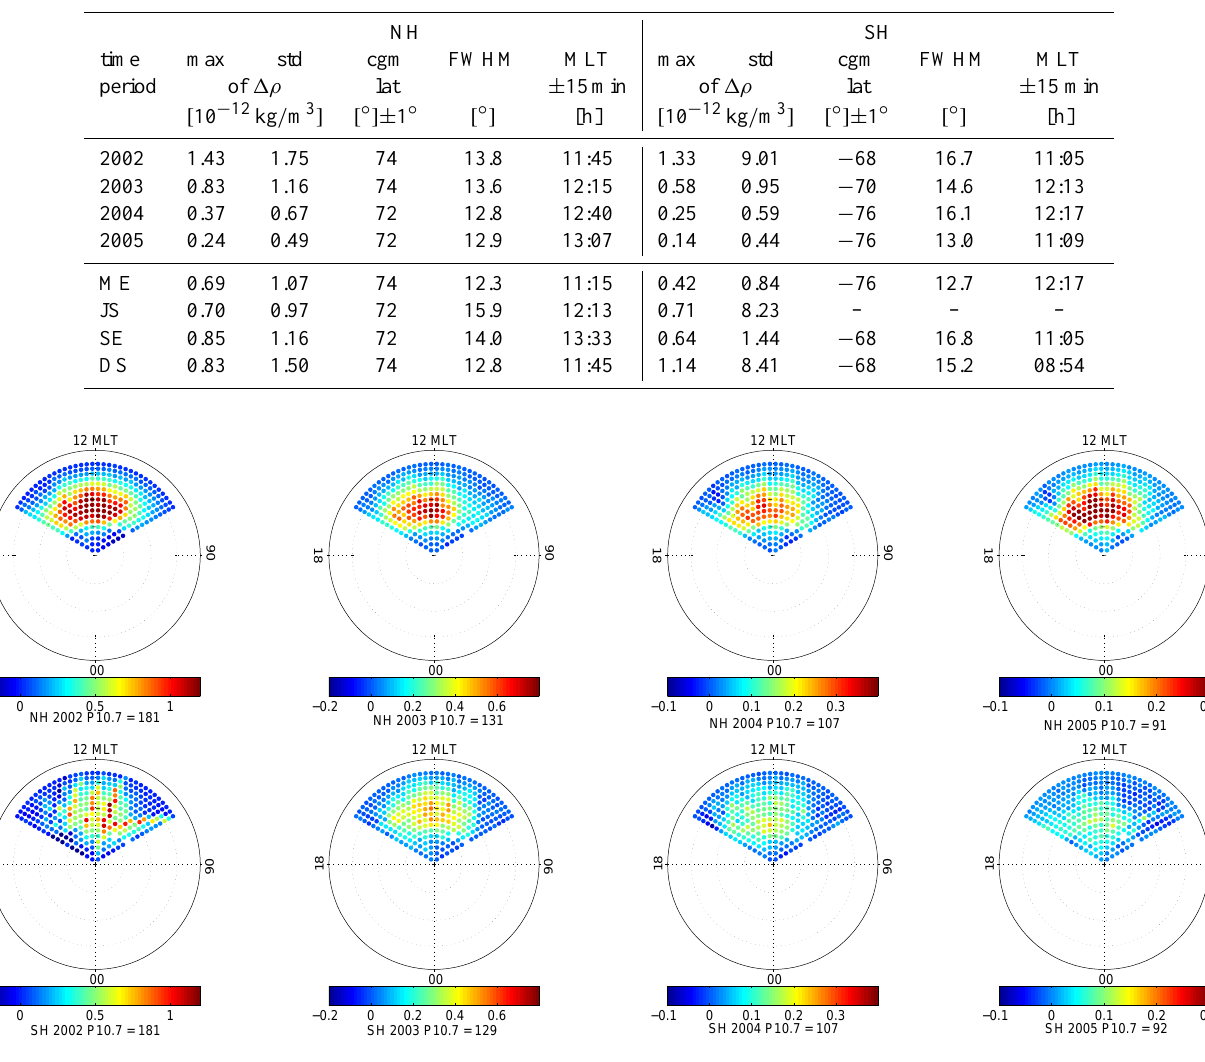
Fig. 4. Statistical survey over four years of the density anomaly amplitude (in 10 − 12 kg / m 3 ) within the dayside polar region of the Northern (upper row) and the Southern (lower row) Hemisphere. Note the different scales. Yearly averaged P10.7 values are listed below the plots.